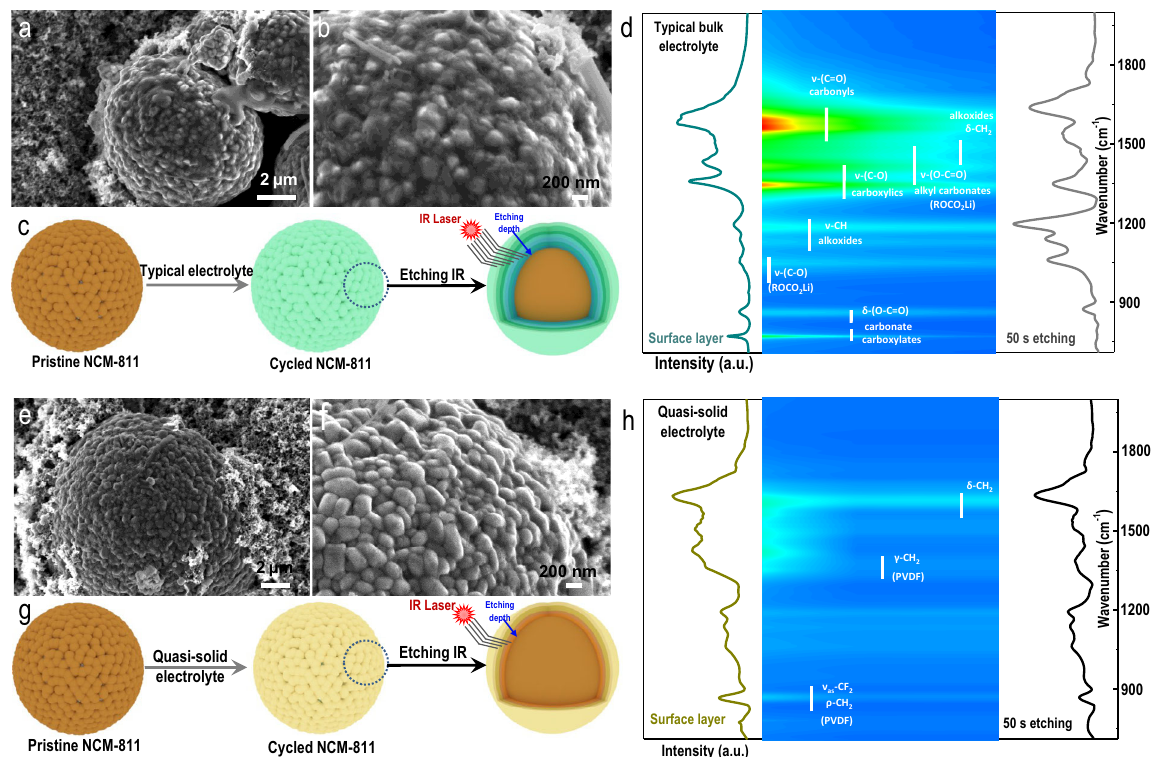
Fig. 4 Characterizations of cycled NCM-811 cathode using both a typical electrolyte and the MOF-based quasi-solid electrolyte. Scanning electron microscopy (SEM) images of the cycled NCM-811 cathode harvested from the NCM-811//Li half-cell assembled with a , b a typical liquid electrolyte (after 50 cycles) and e , f an MOF-based quasi-solid electrolyte (after 300 cycles). Argon-etching Fourier transform infrared spectrum (FT-IR) of the cycled NCM-811 cathode within c a typical liquid electrolyte (after 50 cycles) and g an MOF-based quasi-liquid electrolyte (after 300 cycles). Etching FT-IR spectra and the corresponding color mappings of the cycled NCM-811 cathode using the d typical liquid electrolyte and h MOF-based quasi-solid